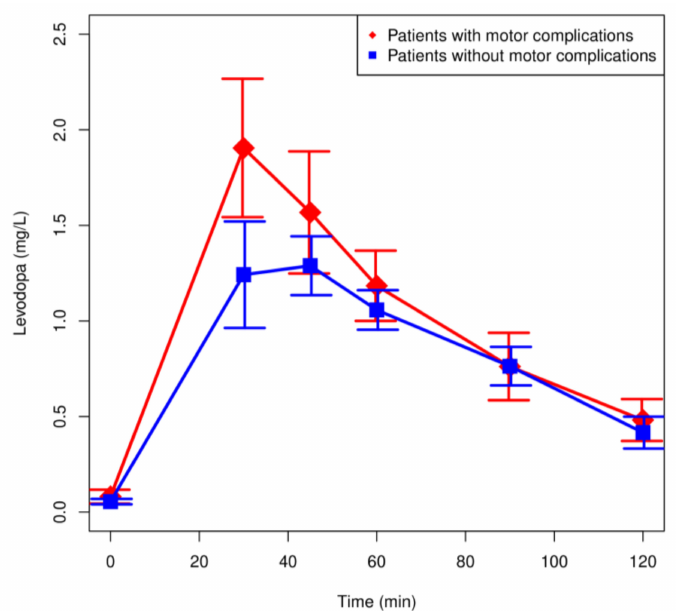
Figure 4. Plasma concentration: time profiles (mean values ± SEM) for levodopa of patients with motor complications (fluctuations and/or dyskinesias) and without motor